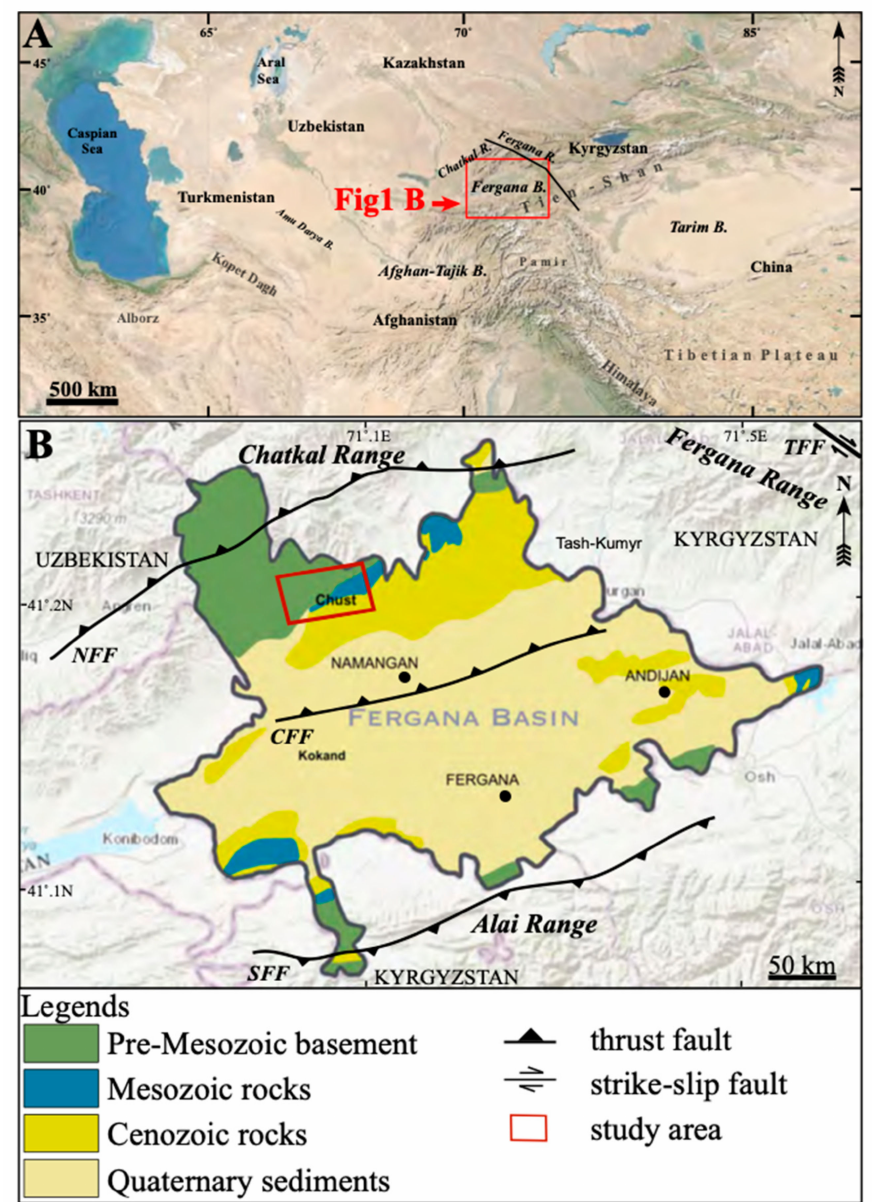
Figure 1. ( A ) Index map of the Republic of Uzbekistan. The map shows the location of the Fergana Basin with regional and adjacent structures around Tien Shan, central Asia. ( B ) Outline geological map of the Fergana Basin (modified from [4]). TFF: Talas–Fergana Fault; NFF: North Fergana Fault; CFF: Central Fergana Fault; SFF: South Fergana